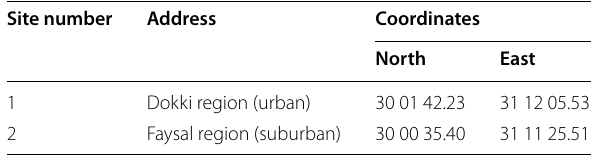
Fig. 1 Measurement locations in Dokki region, blue line refers to measurement road